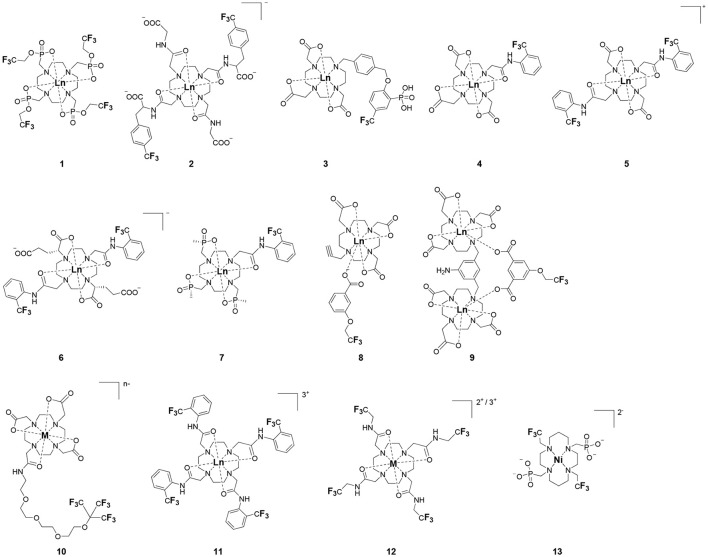
Chemical structures of non-responsive paramagnetic 19F probes (1, Kim et al., 1997; 2, Cakic et al., 2016; 3, Placidi et al., 2013; 4, Chalmers et al., 2010; 5–6, Chalmers et al., 2011a; 7, Chalmers et al., 2011a,b; 8–9, Davies et al., 2015; 10, Jiang et al., 2011; 11, Chalmers et al., 2010; 12, Srivastava et al., 2017a,b; 13, Blahut et al., 2016, 2017).